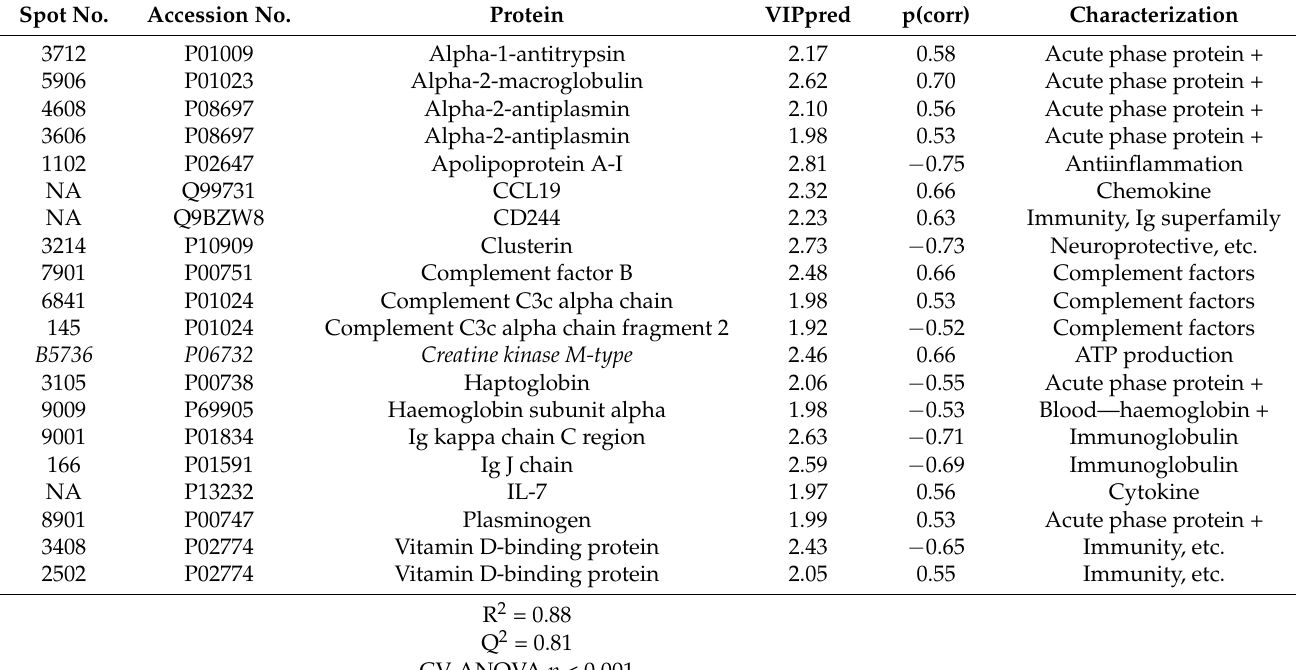
Table 3. OPLS regression of CPT in CWP; significant proteins (in alphabetical order) are presented according to VIPpred. Characterization is based on brief reviews presented in Text S2. Proteins in italics are muscle proteins and the others are plasma proteins. A positive sign of p(corr) indicates that a high level of the protein is associated with a low pain threshold for cold